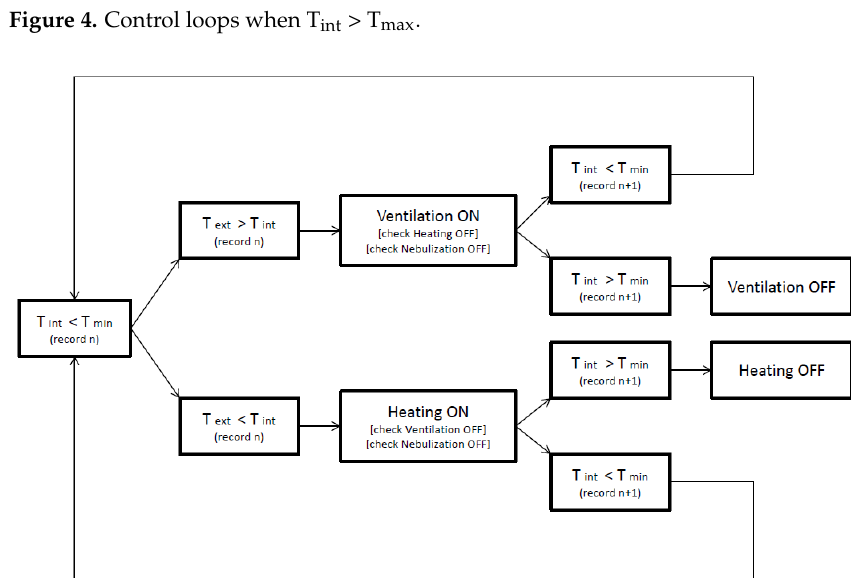
Figure 5. Control loops when T int < T min .